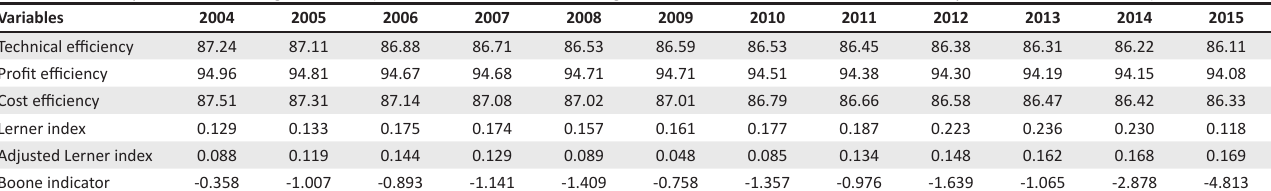
TABLE 4: Summary of statistics for big four banks (Standard Bank, Nedbank, Amalgamated Banks of South Africa [ABSA]/Barclays and First National Bank). Variables